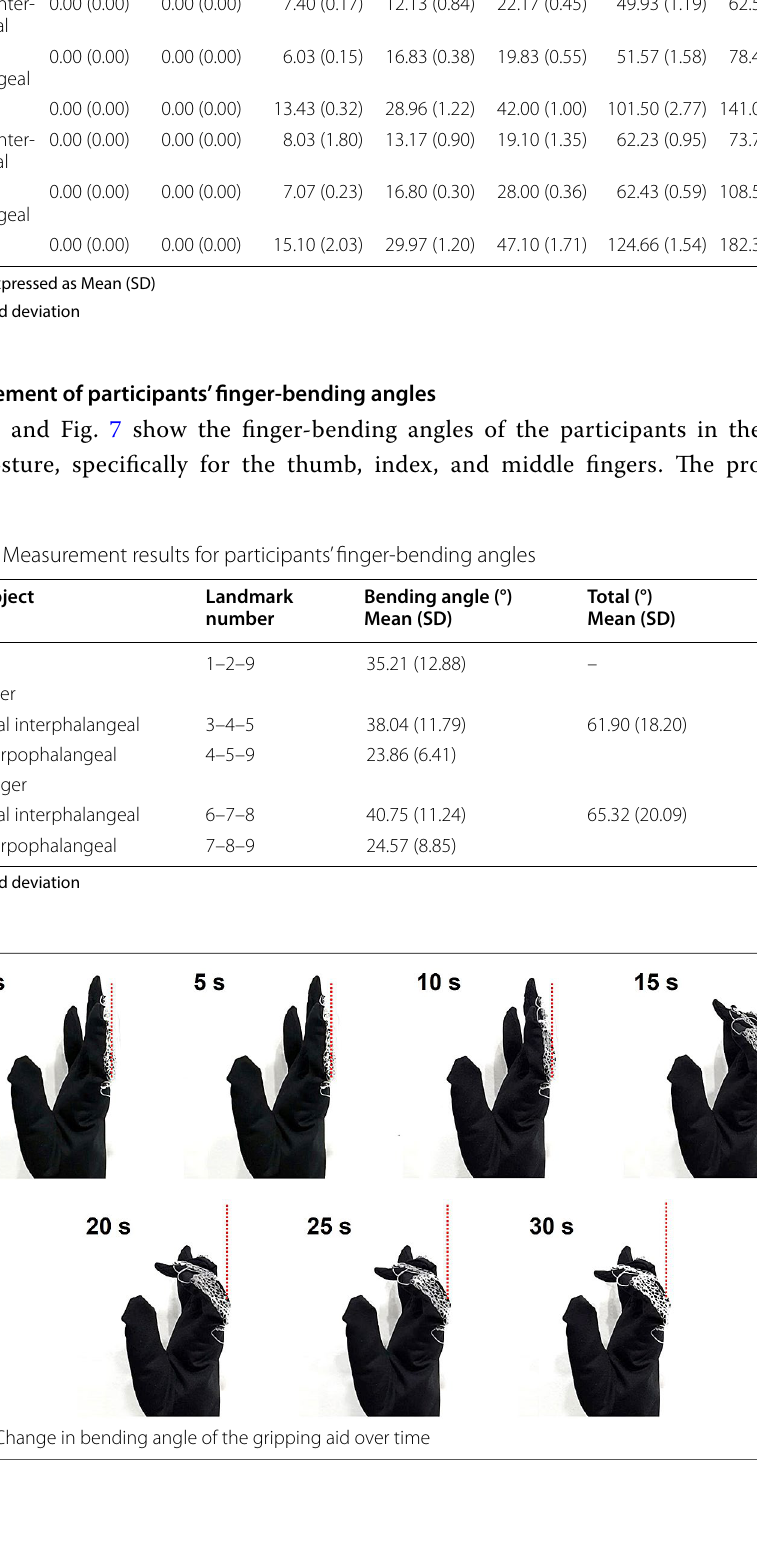
Table 3 Bending angle changes of the knitted shape memory alloy modules Measurement landmark